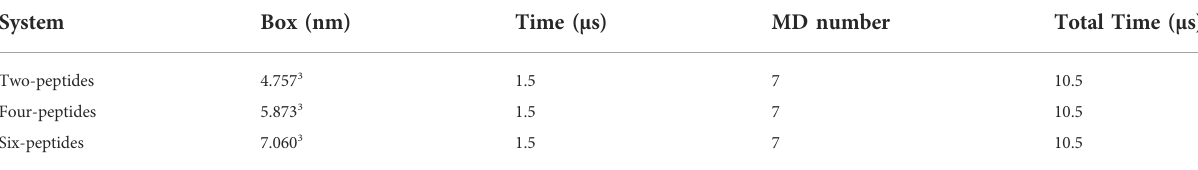
TABLE 1 Details of MD simulations of our research systems. Including the size of simulation box, the number of simulated peptides, the time of each MD simulation, the number of MD (run) simulations and the total MD simulation time.